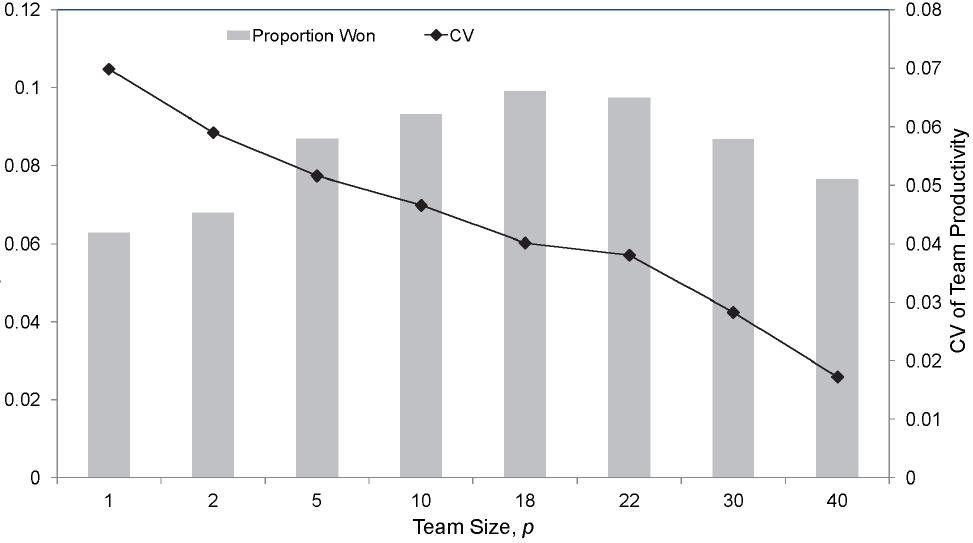
Figure 6. The proportion of premierships won for a single tanking team as a function of the number of players that constitute a team. The mean coefficient of variation of the team productivities for a particular year across all teams, years and simulations is also shown. This assumes the base-case parameter set, with a single team tanking.